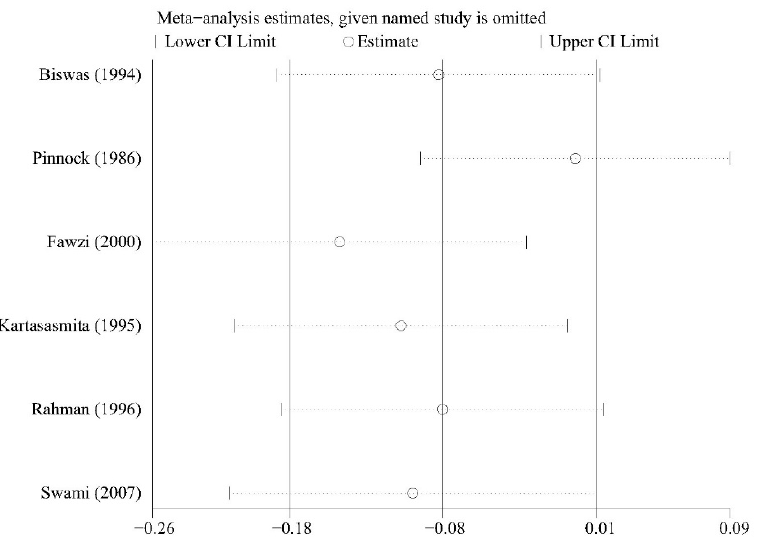
Figure 6. Sensitivity analysis of acute respiratory tract infection (ARTI) incidence.